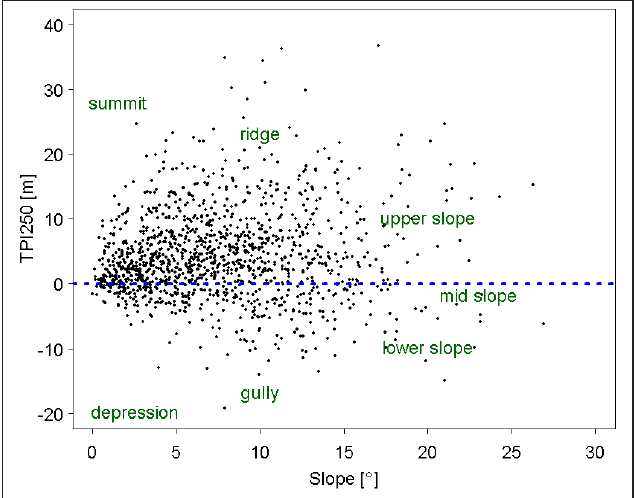
Figure 8: Scatter plot of the mapped SaS illustrating their relief position using SLOPE and TPI250.